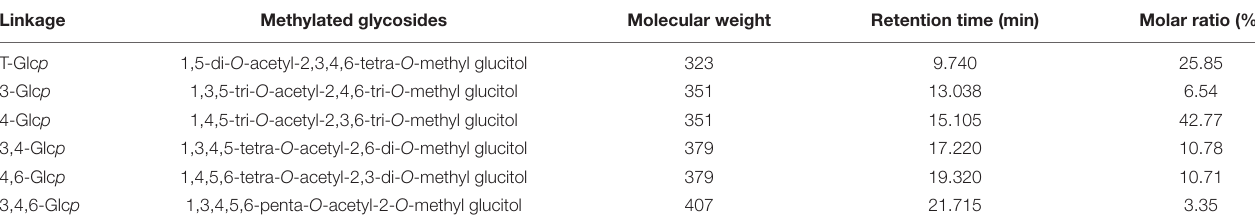
TABLE 1 | Gas chromatography-mass spectrum (GC-MS) analysis of methylated alditol of Chuanminshen violaceumis polysaccharide (CVP) polysaccharide (detailed information had been shown in Supplementary Figure 2 ).